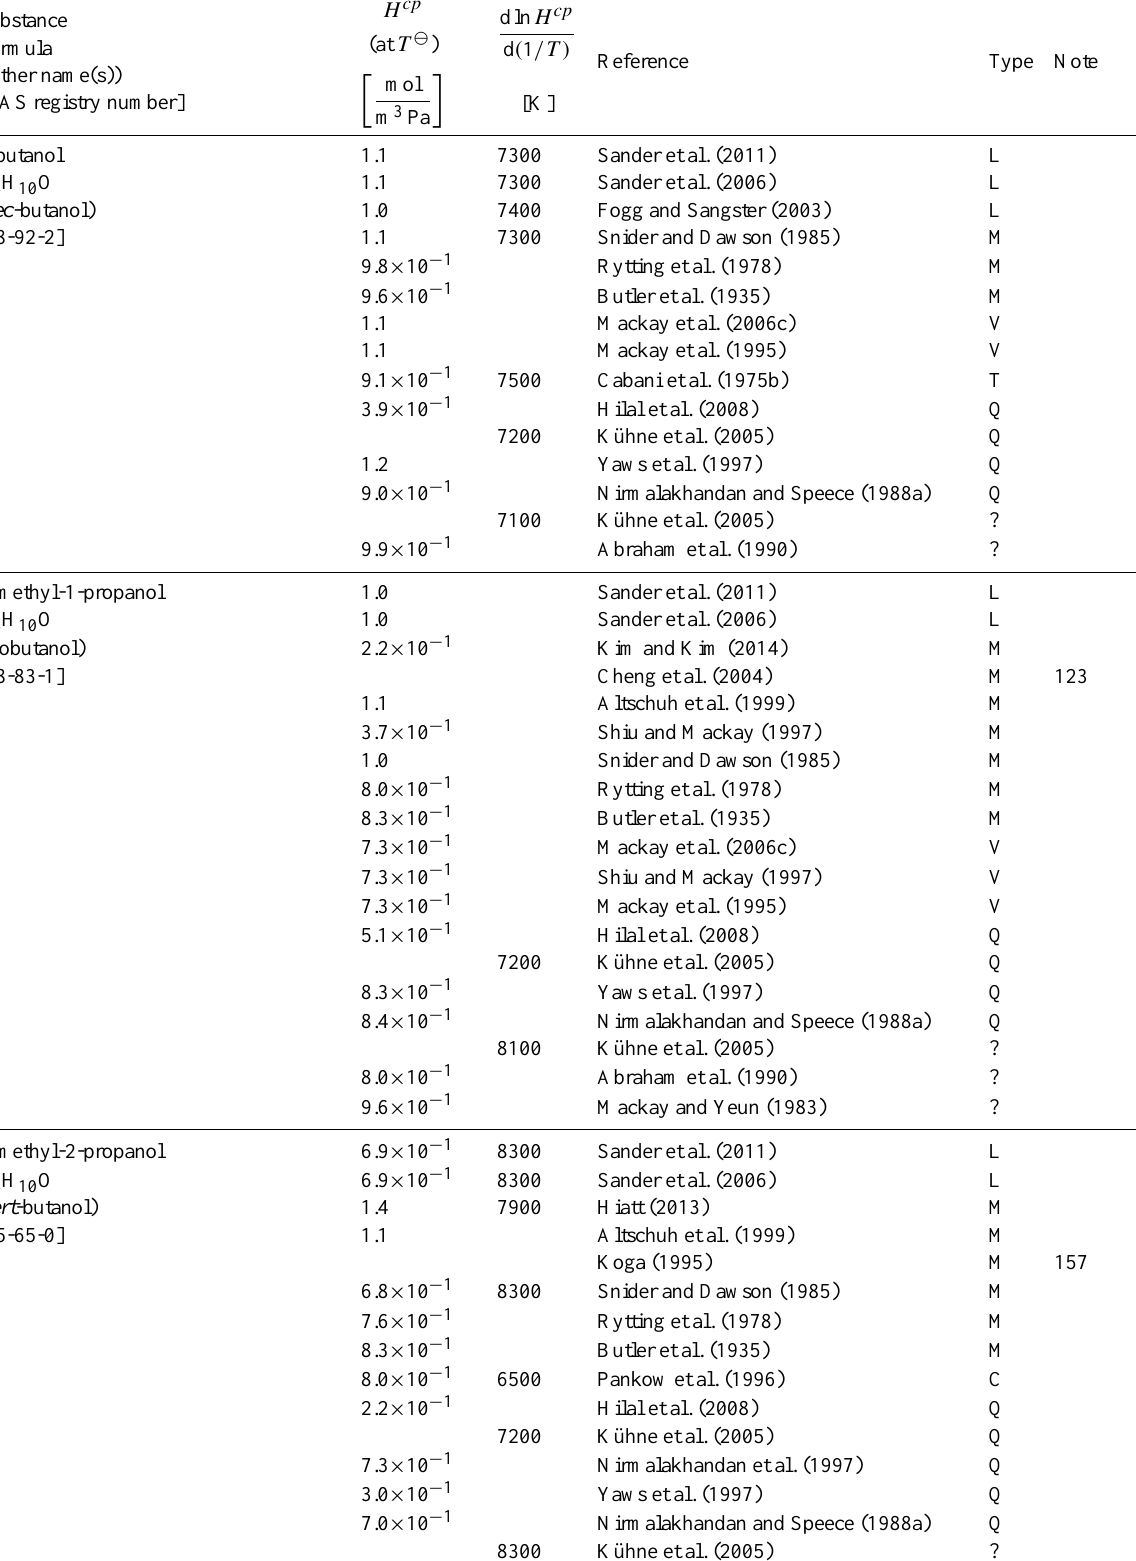
Table 6: Henry’s law constants for water as solvent